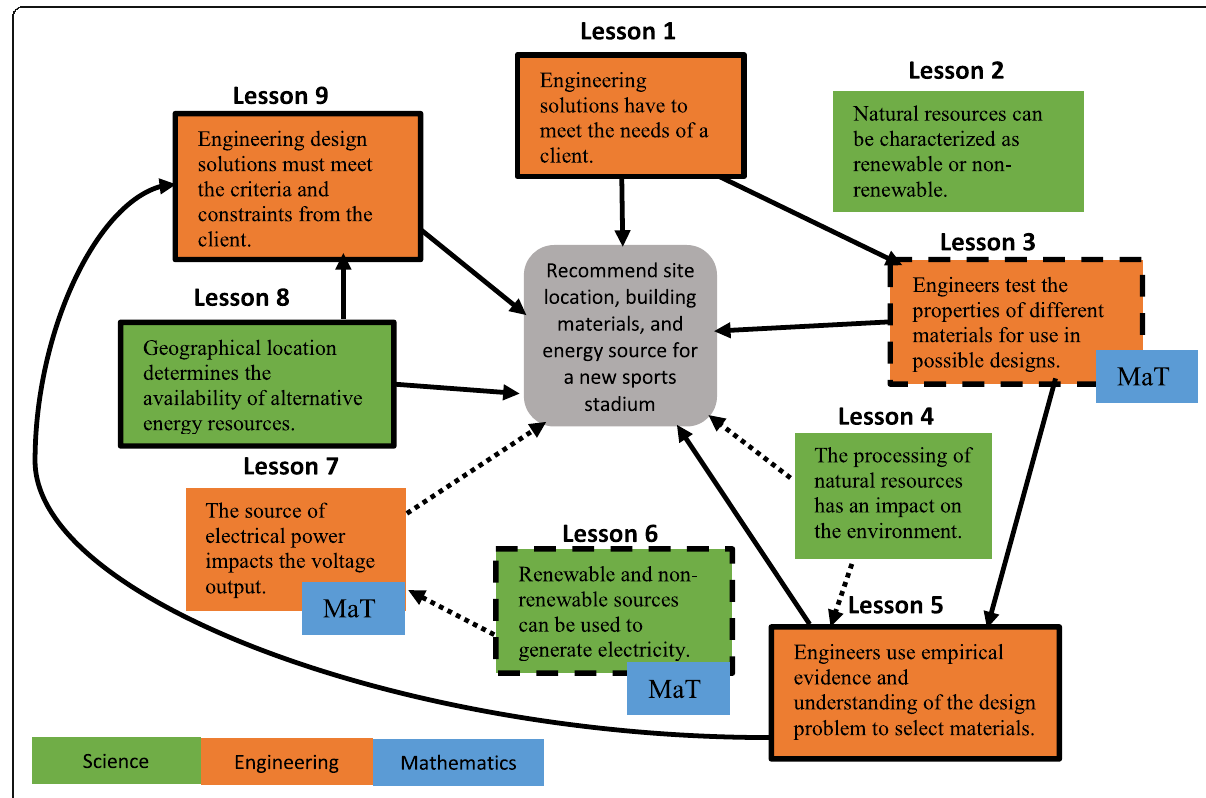
Fig. 3 Conceptual flow graphic for the New Stadium